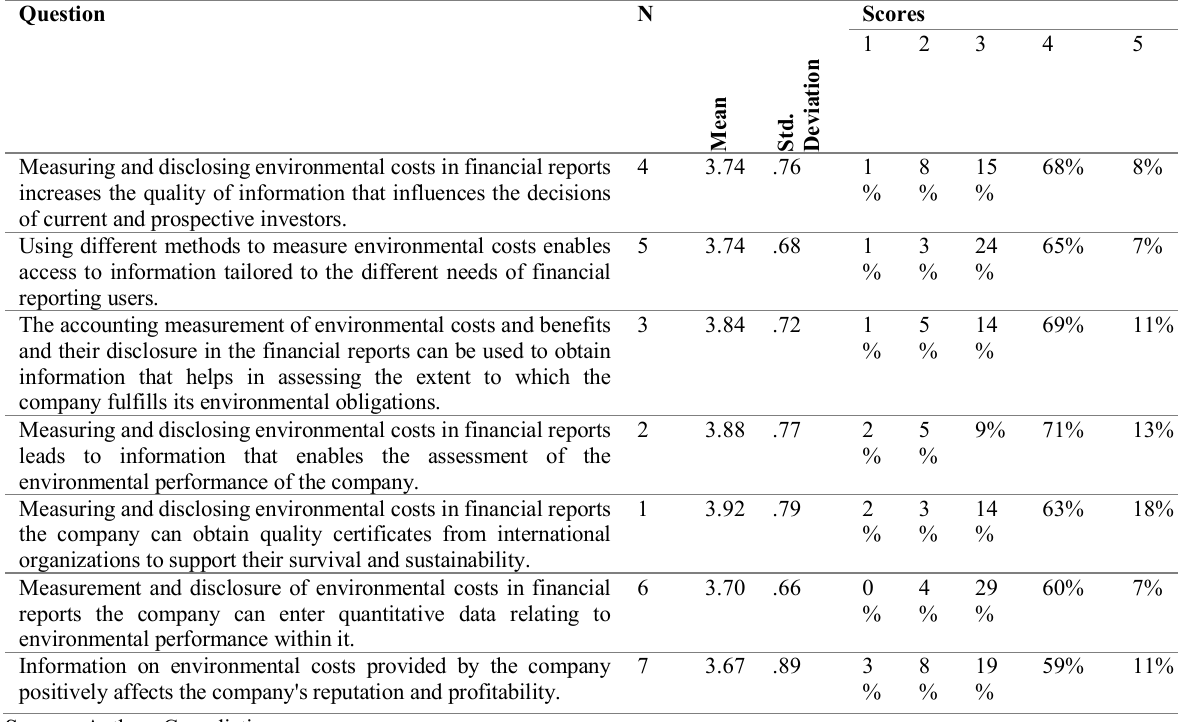
Table 9: Relationship between environmental costs and an increase in the quality of financial